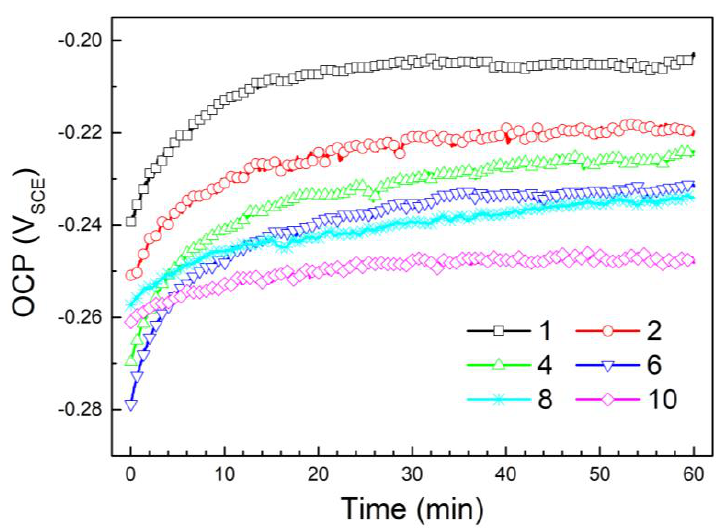
Figure 4. Open circuit potential curves of specimens in the Ca 2+ and Mg 2+ -free solutions with different concentration ratios from 1 to 10 times for 60 min.